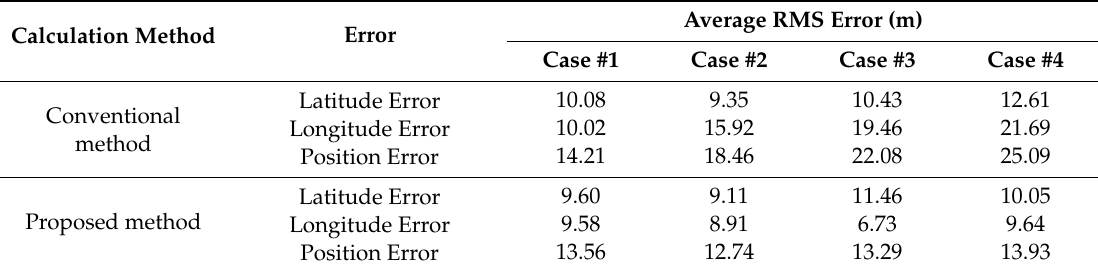
Table 4. Simulation